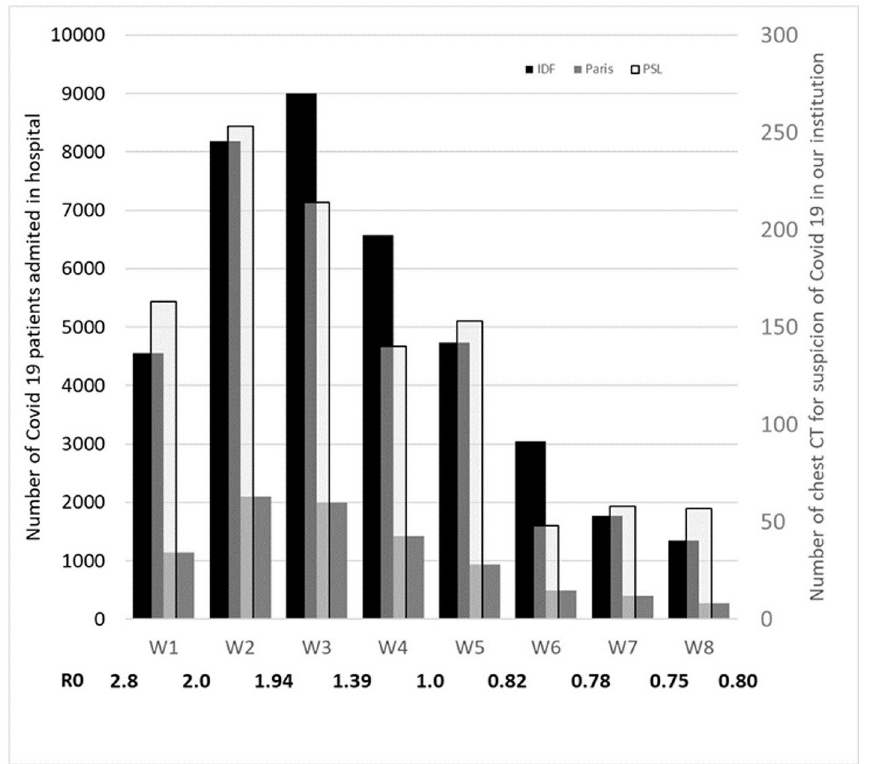
Fig 2. R0, number of COVID 19 patients admitted in the hospital and number of positive RT-PCR in our institution. Number of COVID-19 patients admitted in the hospital in the whole area around Paris (Ile de France: IDF) and in the city of Paris (Paris) (left axis) and number of positive RT-PCR in our institution (PSL) (right axis) and value of R0 as a function of weeks elapsed since the beginning of the confinement W1 = 18–24 of March, W2 = 25–31 of March, W3 = 01–07 of April, W4 = 08–14 of April, W5 = 15–21 of April, W6 = 22–28 of April, W7 = 29 of April-5 of May, W8 = 06–12 of